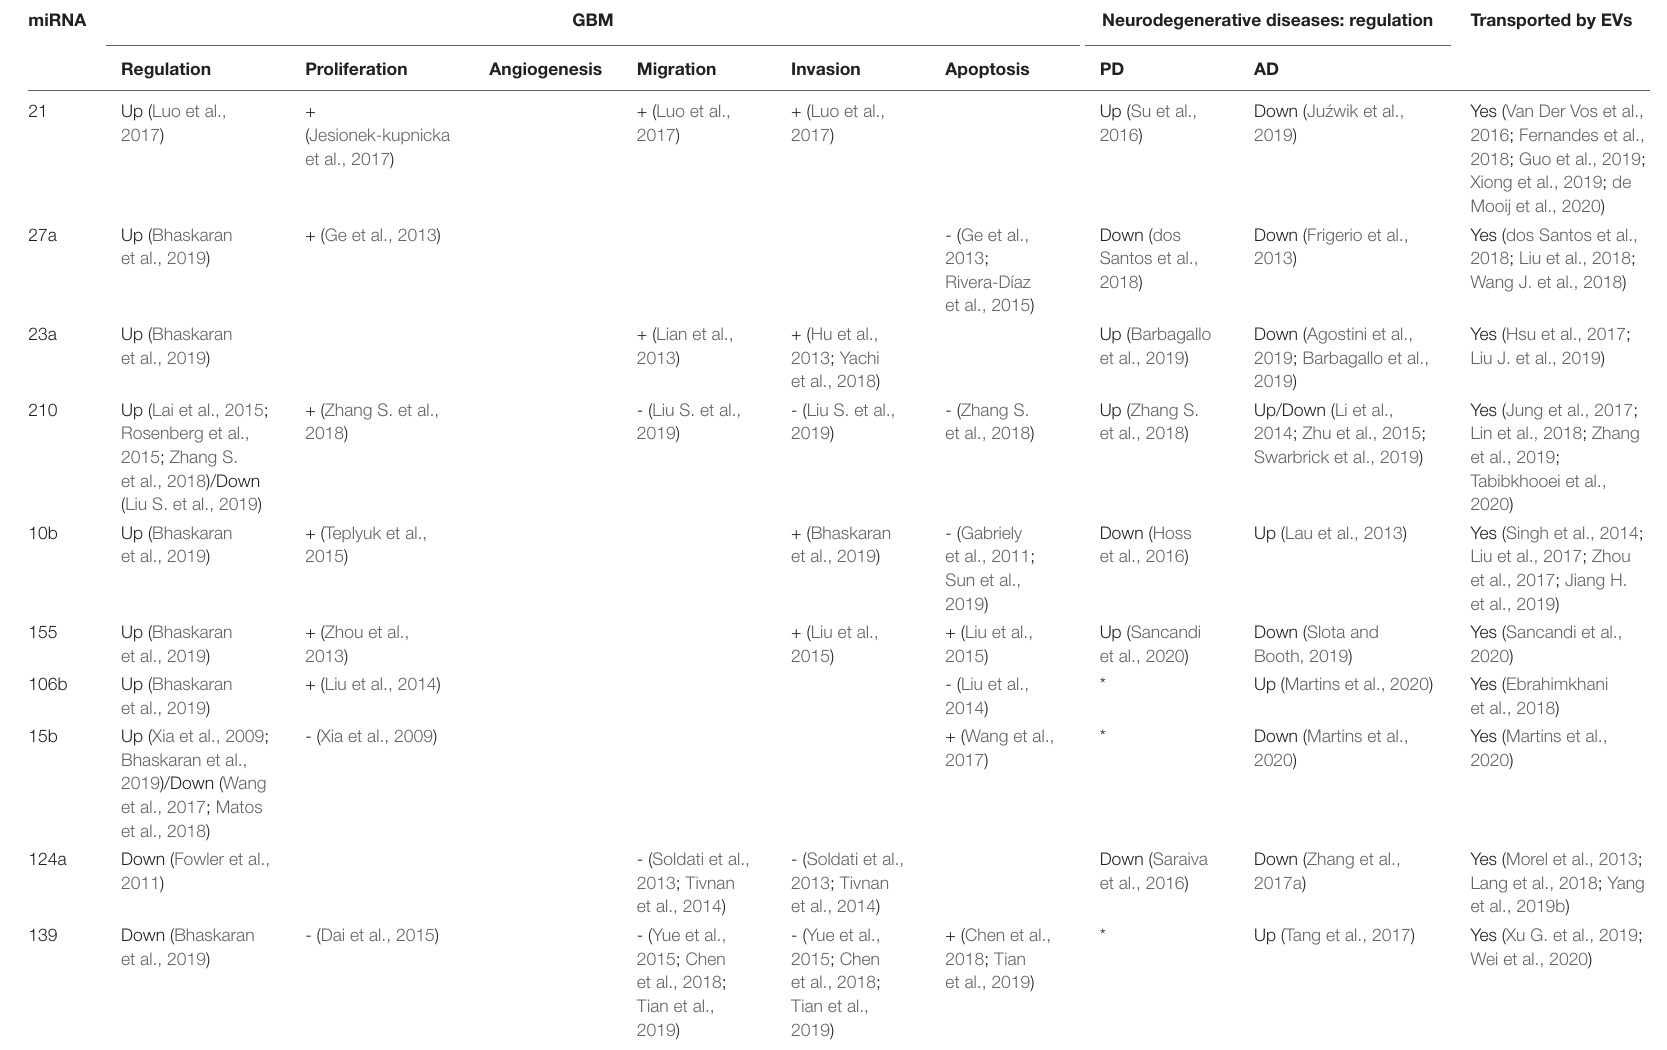
TABLE 1 | Expression of the most deregulated miRNAs in GBM described in this work, their influence on proliferation, angiogenesis, invasion, migration, and apoptosis and their regulation in PD and AD. miRNA GBM Neurodegenerative diseases: regulation Transported by EVs Regulation Proliferation Angiogenesis Migration